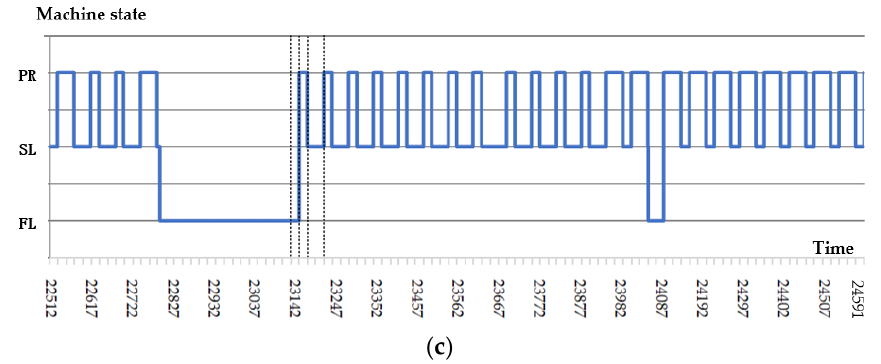
Figure 6. A random sampled simulation in S3 at each decision time point: ( a ) Level of buffer before/after M 2 ; ( b ) Processing rate of M 2 ; ( c ) State change of M 2 .